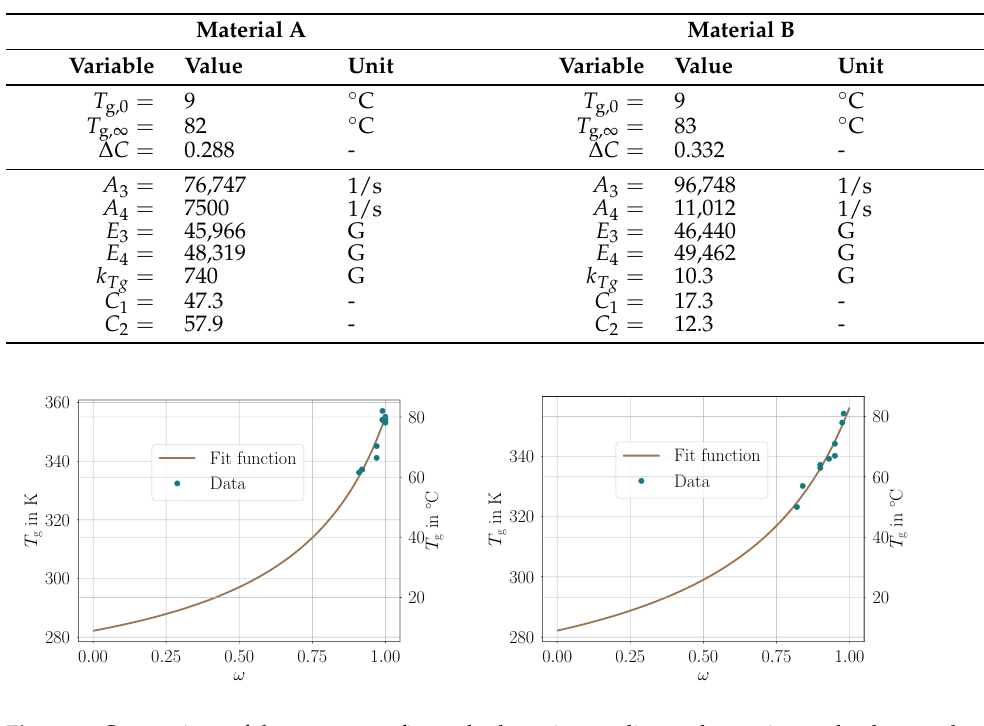
Figure 2. Comparison of the parameter fit resulted continuous line and experimental values as dots from Table 1. Left : material A. Right : material B. Parameters are in Table 4. Isothermal measurements for material A is demonstrated in Figure 3 and for material B in Figure 4 with parameters compiled in Table 4.